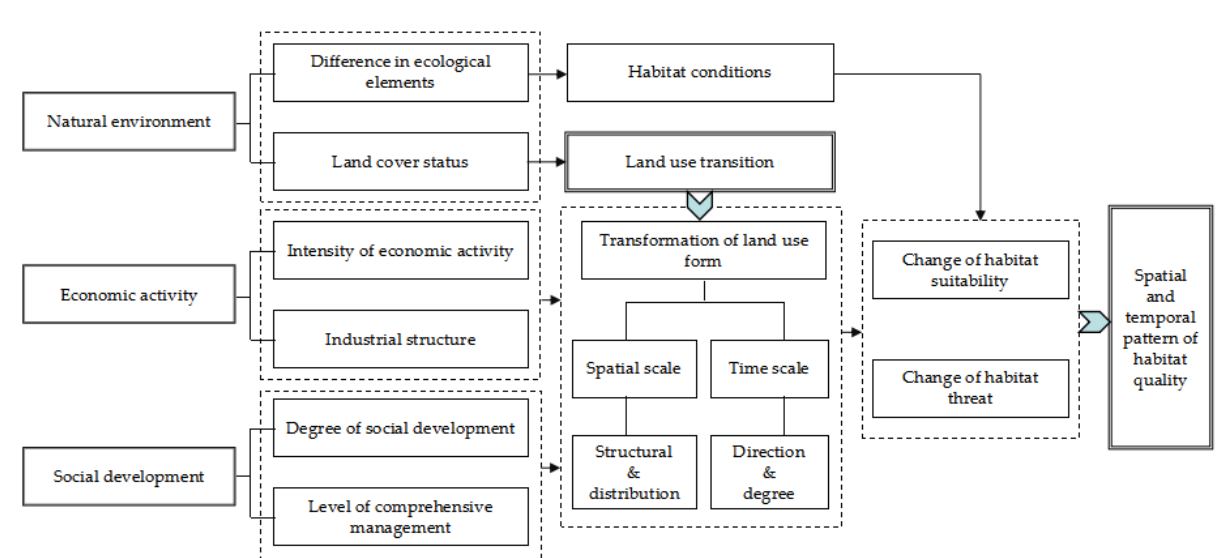
Figure 9. Mechanism of land use transitions affecting habitat quality change.